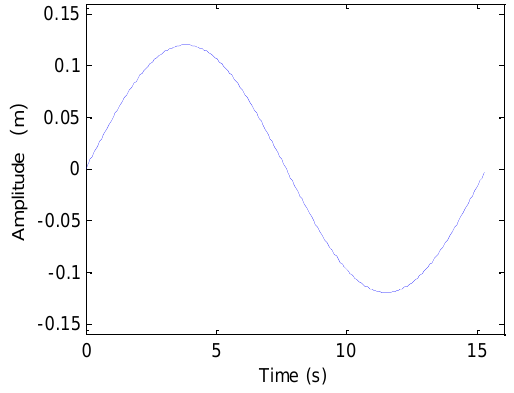
Figure 7. Sinusoidal perturbation.